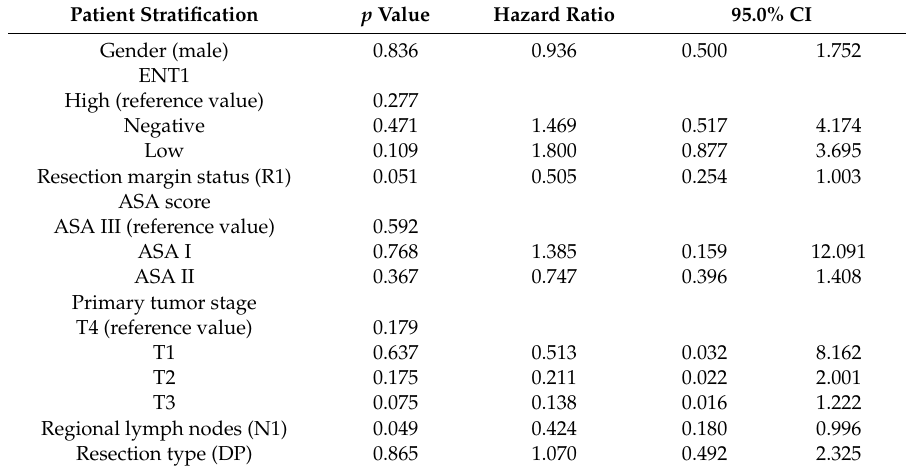
Table 5. Results of multivariate analysis (Cox’s proportional hazards model) of the e ff ect of clinical and pathological characteristics and ENT1 protein levels analyzed by immunohistochemistry in FFPE samples on patients’ DSS.